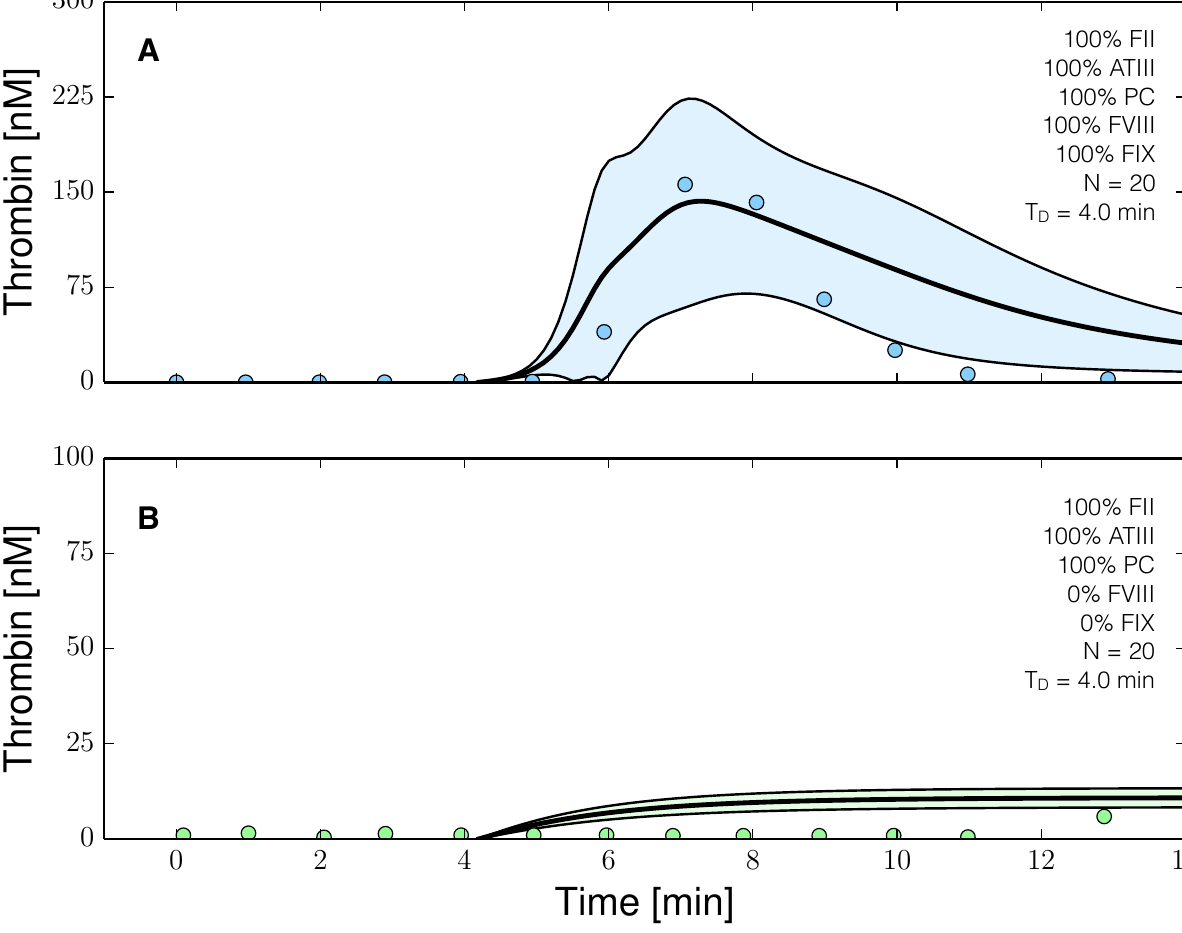
Figure 6. Reduced order coagulation model predictions versus experimental data with and without coagulation factors VIII (fVIII) and IX (FIX). The reduced order coagulation model parameter estimates were tested against data not used during model training. Simulations of normal thrombin formation with ATIII and the protein C pathway were compared with thrombin formation in the absence of fVIII and fIX. Solid lines denote the simulated mean value of the thrombin profile for N = 20 independent particles, points denote experimental data. The shaded region denotes the 99% confidence estimate of the mean simulated thrombin value (uncertainty in the model simulation). ( A , B ) prediction results for normal thrombin generation and thrombin generation in hemophilia. All factors and control proteins were at their physiological concentration unless others noted. Coagulation was initiated with 0.2 nmol/L FVIIa. The experimental validation data was reproduced from the study of Allen et al.